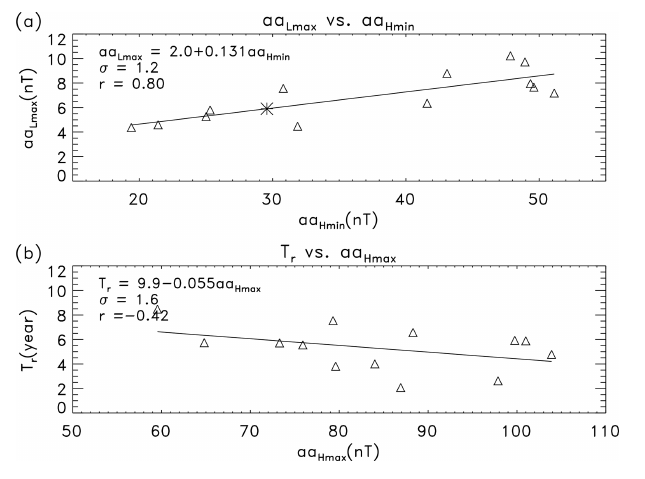
(a) and T r against min